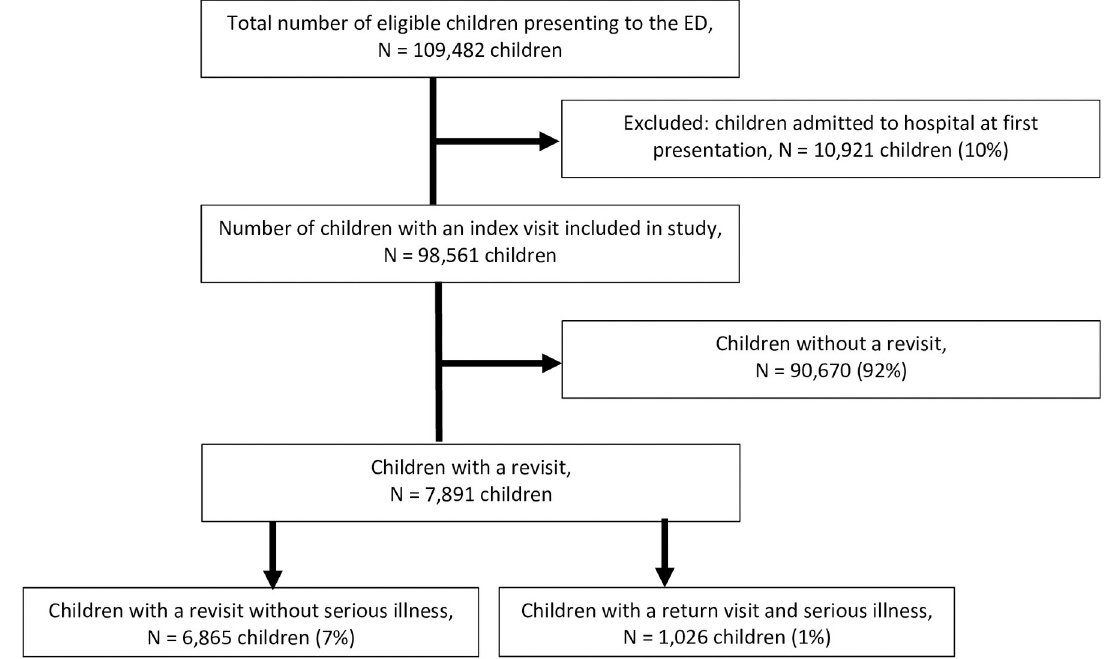
Fig 1. Flowchart of included population. Flowchart with exclusion criteria and the included